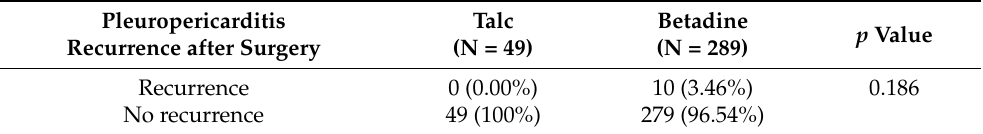
Table 4. Recurrence of pleuropericarditis after surgery by pleurodesis treatment.